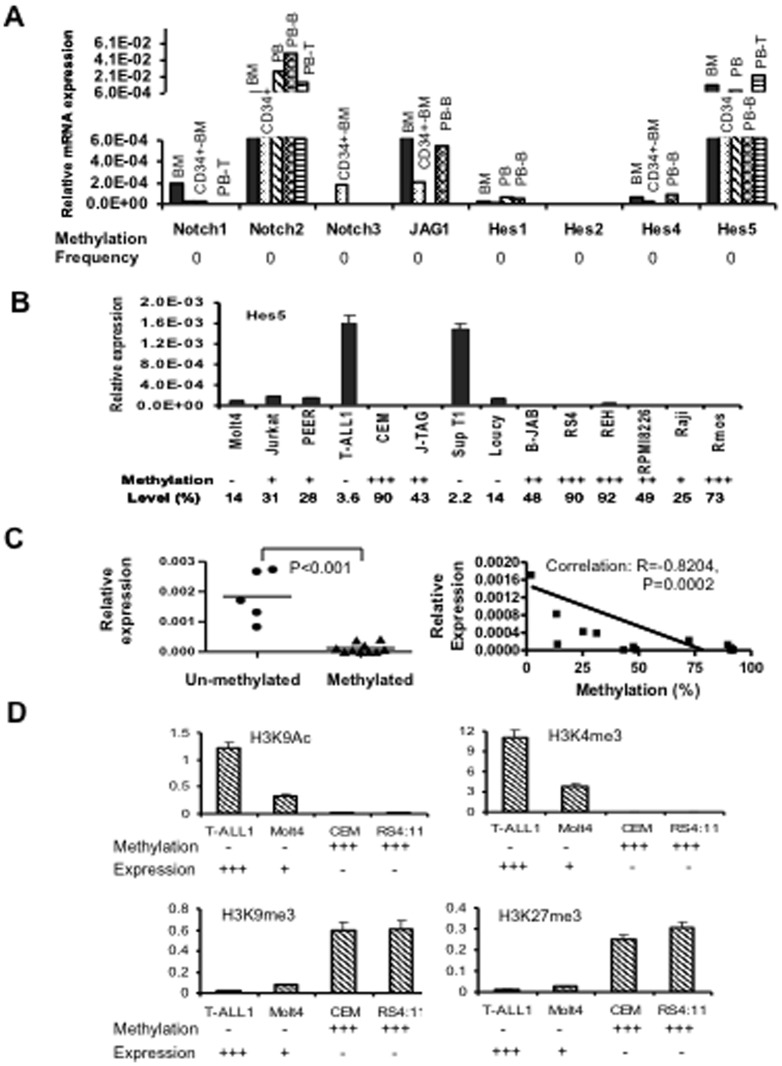
Expression and histone modification analysis of Hes5 genes in leukemia cell lines and normal hematopoietic lineages.
A. Expression levels of Notch1, Notch2, Notch3, JAG1, Hes1 and Hes5 in normal whole bone marrow (BM), CD34+BM, peripheral blood (PB), CD19+ B cells (PB-B) and CD3+ T cells (PB-T). The relative gene expression was determined by real-time PCR assays and normalized to GAPDH. B. Hes5 mRNA expression levels in leukemia cell lines by RT-PCR. Hes5 methylation levels from Figure 1A are shown under each cell lines. C. left. Hes5 expression is significantly lower in Hes5 methylated cell lines when compared with unmethylated cell lines. C. right. Hes5 mRNA expression inversely correlated to methylation level. The solid line represents the regression of the degree of methylation on the Hes5 expression level. D. ChIP assay of the Hes5 CpG islands. Chromatin DNA was immunoprecipitated with antibodies against the indicated histone modifications. Immunoprecipitated DNA was amplified by real-time PCR. Percent input was determined as the amount of immunoprecipitated DNA relative to input DNA. Experiments were performed in duplicate. Bars, SD.